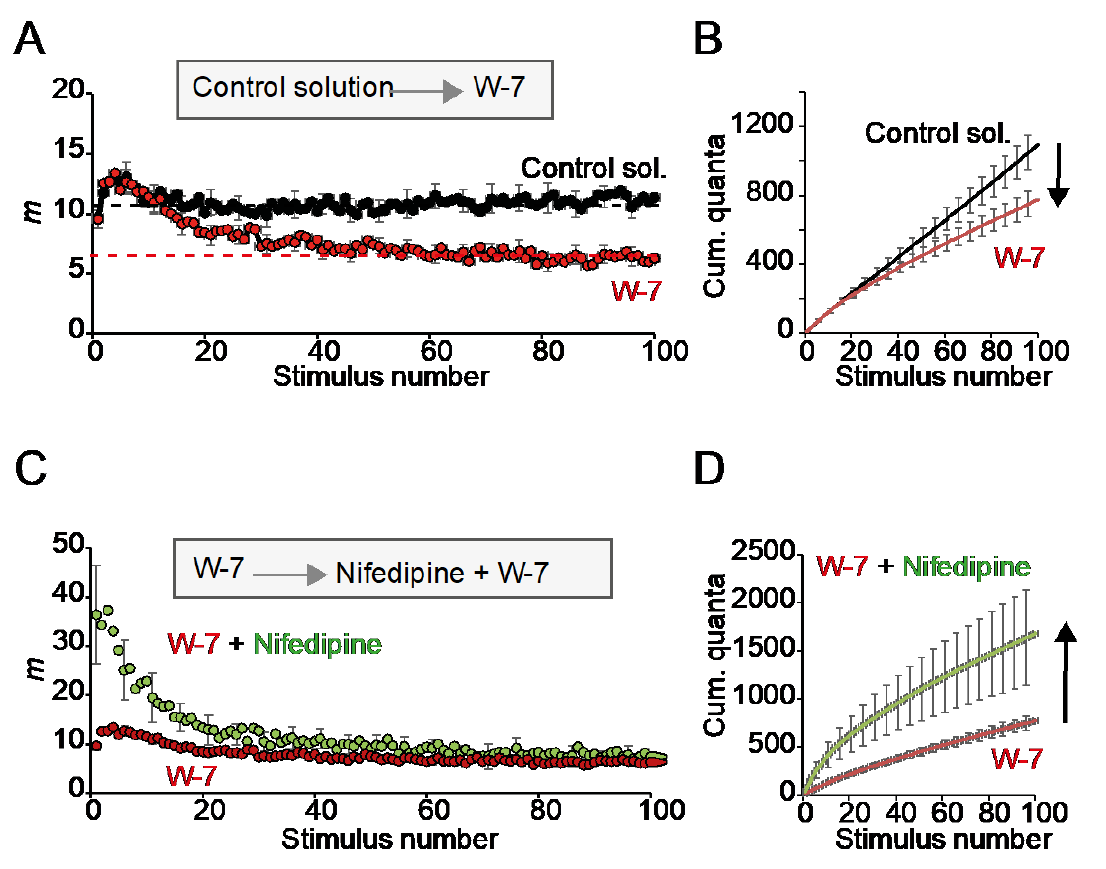
Figure 6. Effect of W-7 on secretion during repetitive high-frequency stimulation. ( A ) Average quantal content ( m ) in the absence (control solution) and presence of the CaM inhibitor W-7. Observe the increases in short-term depression (STD). ( B ) Mean cumulative release from recording in ( A ). ( C ) Average quantal content in the presence of W-7 and after adding nifedipine. ( D ) Mean cumulative release from recording in ( C ). The arrows represent the directions and amplitudes of the changes.